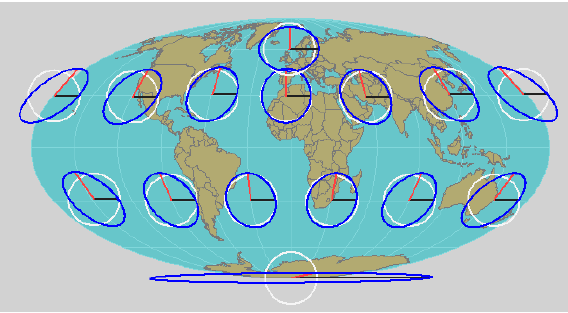
Fig. 5. The presentation of the distribution of distortions using the Tissot’s ellipses (source: